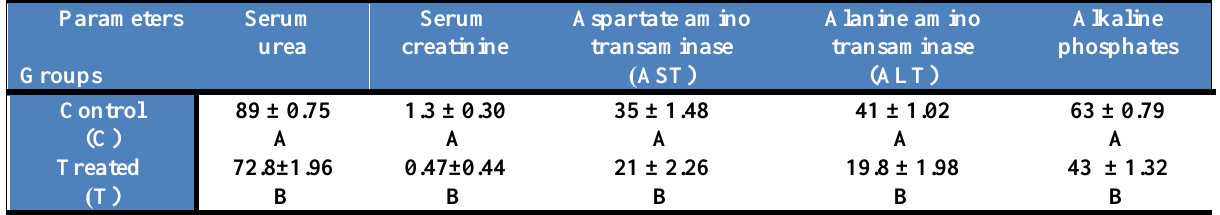
Table, 1: Effect of ethanolic extract from Metracaria chamomella on some serum biochemical parameters in male rabbits.